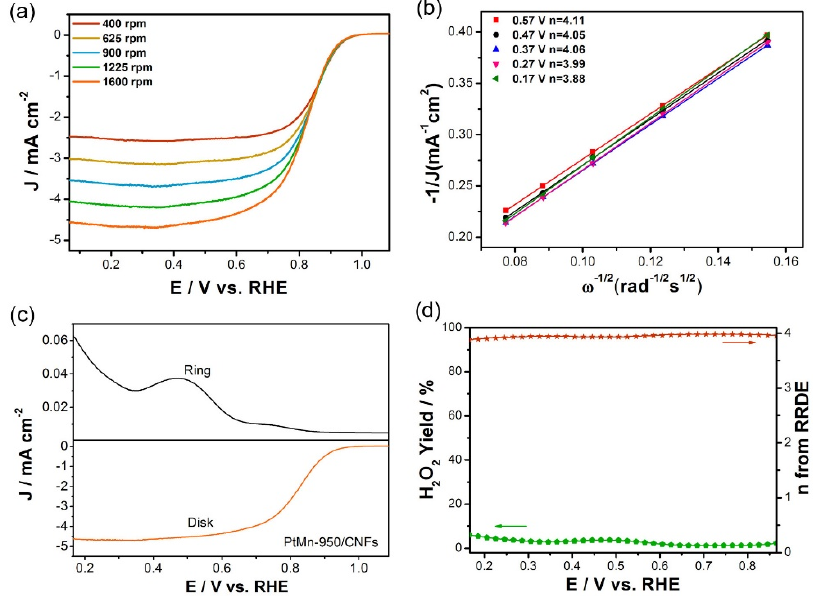
Figure 5. ( a ) ORR polarization curves of PtMn ‐ 950/CNFs at different rotation rates in O 2 ‐ saturated 0.10 M KOH. ( b ) Koutecky ‒ Levich plots of PtMn ‐ 950/CNFs at different potentials. ( c ) ORR polarization curves recorded on the RRDE for PtMn ‐ 950/CNFs in O 2 ‐ saturated 0.10 M KOH solution at 1600 rpm. ( d ) The calculated H 2 O 2 yield and electron transfer numbers ( n ) for PtMn ‐ 950/CNFs.